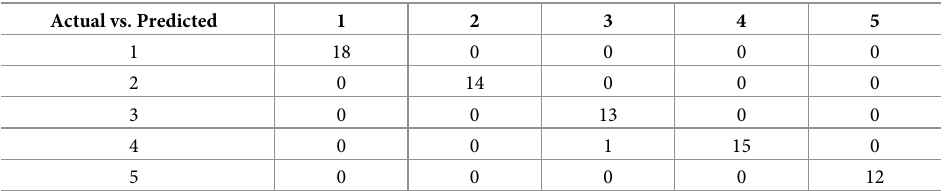
Table 3. Confusion matrix output result table. Actual vs. Predicted